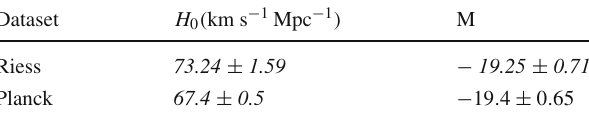
Table 2 Values of { H 0 , M } used in analysis SNe data, derived using the values in [3] as reference. The first row shows the values from [3], and the second row the value of H 0 from [2] and the implied value of M obtained using Eq. (13). The publicly available values are in italics, while the value of M for Planck, inferred using Eq. (13), is in